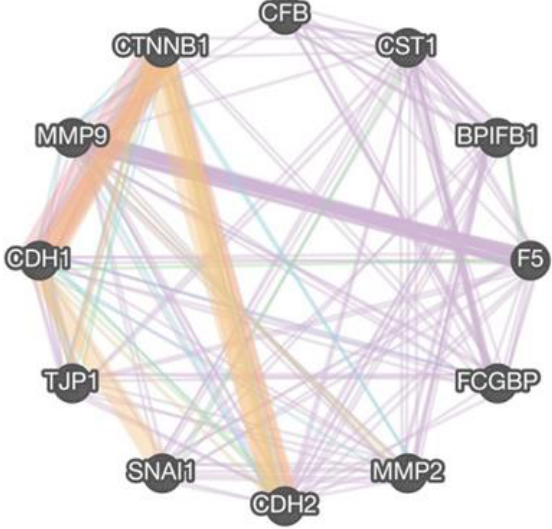
Figure 7. FCGBP , CST1 , F5 , CFB , and BPIFB1 correlate with EMT pathway. Gene – gene interaction network of selected candidate genes; FCGBP , CST1 , F5 , CFB , and BPIFB1 with EMT genes; CDH1 , CDH2 , TJP1 , CTNNB1 , and SNAI1 , as well as cell-migration-related genes MMP2 and MMP9 generated by GeneMANIA (http://genemania.org/; accessed on 11 November 2021) to identify interactions between the candidate genes with EMT and cell migration markers. The different colors of the network edge indicate the bioinformatics methods applied: website prediction (orange), physical interactions (red), co-expression (purple), shared protein domains (brown), pathway (light blue), co-localization (dark blue), and genetic interactions (green).